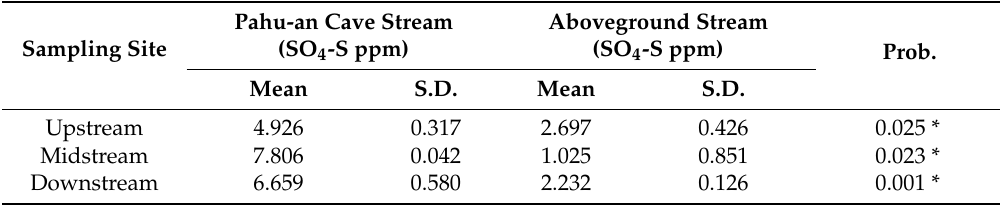
Table 7. Sulfate content (sediments).